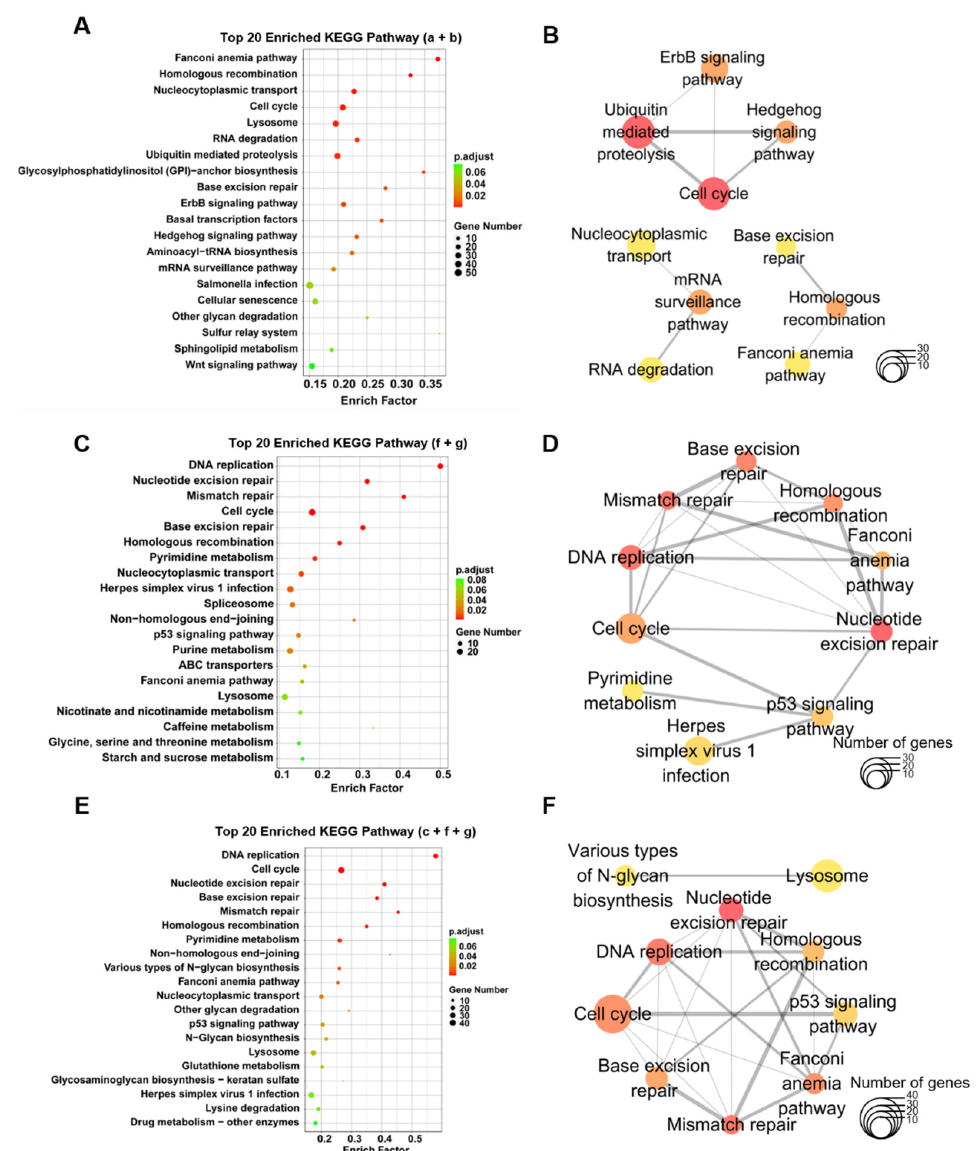
Figure 5. Hub signaling pathways from KEGG enrichment analysis of genes specifically expressed in hepatocytes at different stages. Dot plots of KEGG signaling pathways ( A ) and networks of top 10 hub pathways ( B ) for genes specifically expressed from 60 to 72 hpf (a and b). Dot plots of KEGG signaling pathways ( C ) and networks of top 10 hub pathways ( D ) for genes specifically expressed from 72 to 96 hpf (f and g). Dot plots of KEGG signaling pathways ( E ) and networks of top 10 hub pathways ( F ) for genes specifically expressed from 60 to 96 hpf (c, f and g). Node color stands for the enrichment p-value in the pathway. Table 2. Top 10 hub pathways of genes included in a and b ranked by MCC method.